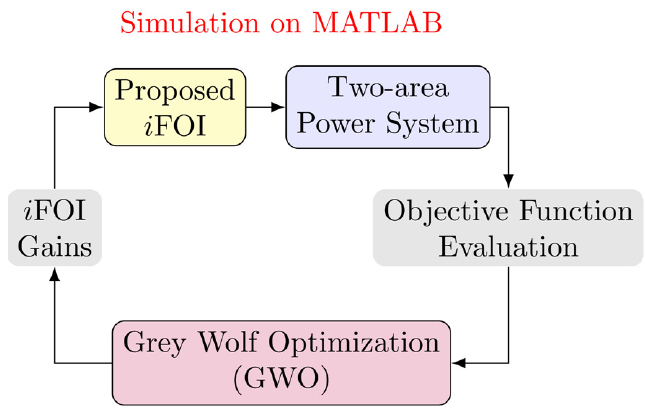
Figure 6. Tuning process of the proposed iFOI.